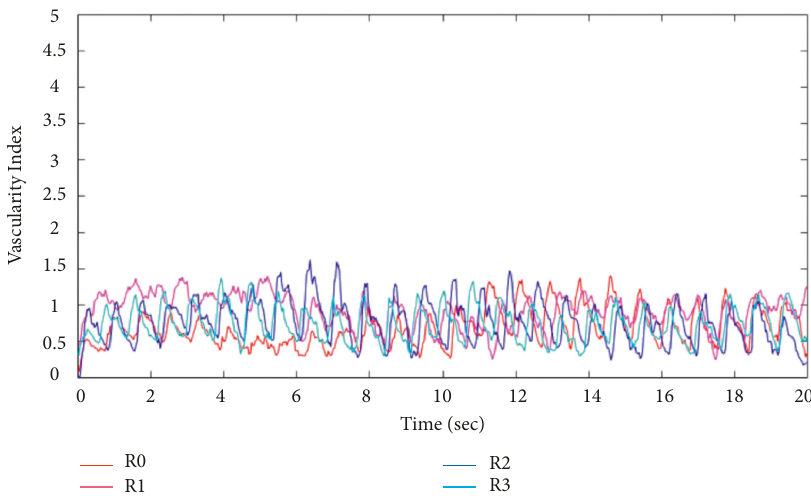
Figure 3: Vascularity index (VI) calculated from images of one participant.